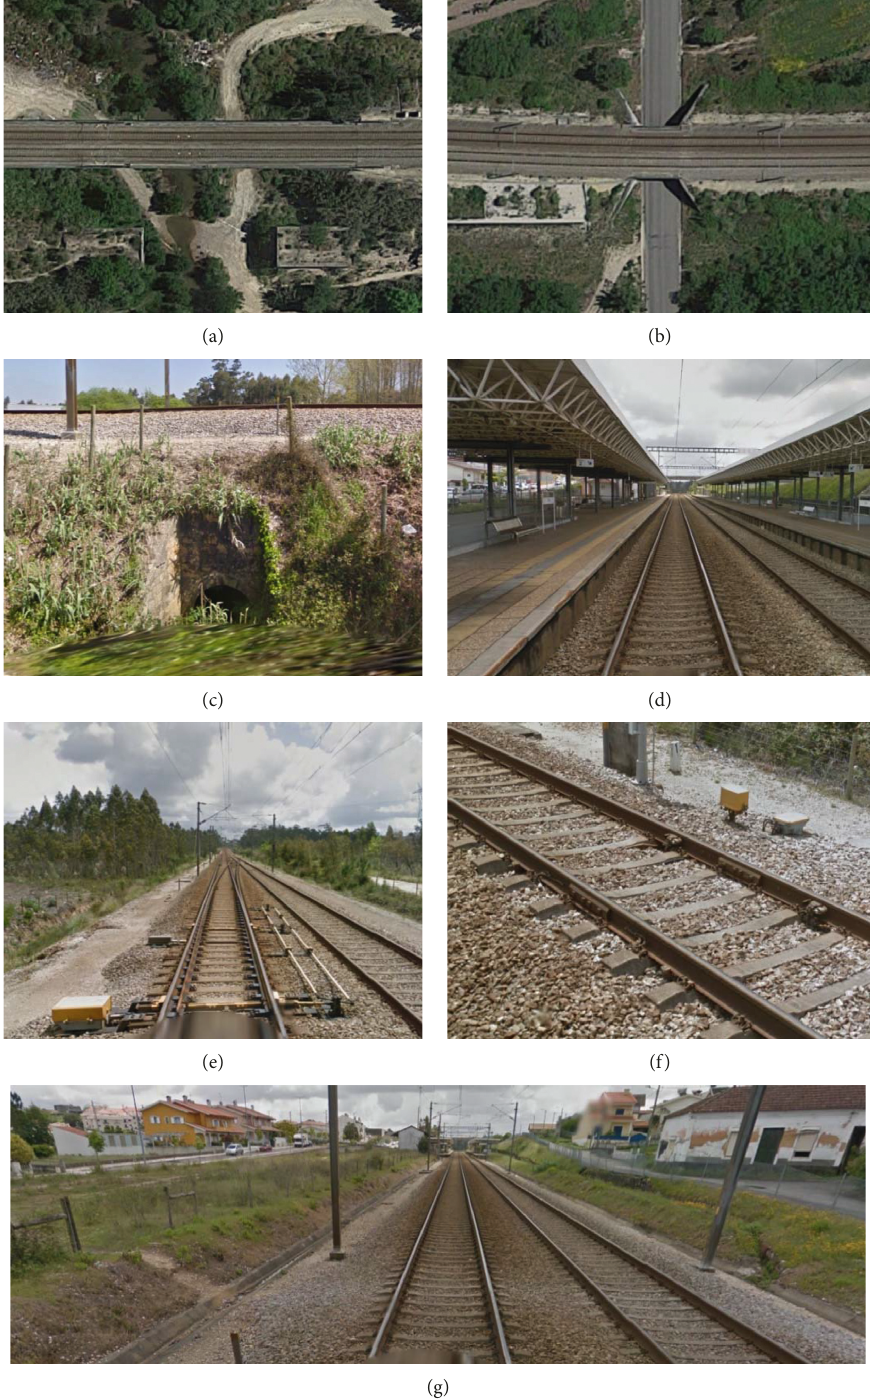
Figure 5: Different types of track discontinuities found along the line (Imagery: Google Street View): (a) bridge, (b) road underpass, (c) culvert, (d) train station, (e) turnout, (f) rail joint, and (g) unauthorized pedestrian